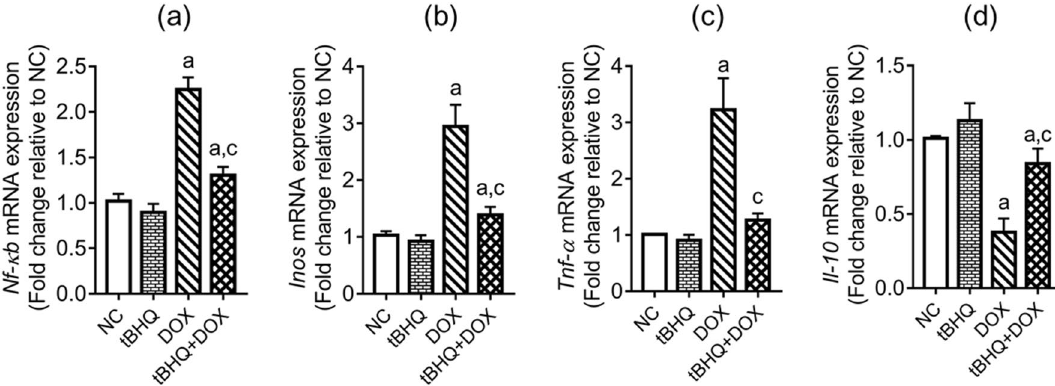
Figure 5. Effect of tBHQ on Nf-κb ( a ), Inos ( b ), Tnf-α ( c ) and Il-10 ( d ) mRNA levels in the testis of DOX- treated rats. NC: normal control, tBHQ: tert-butylhydroquinone, DOX: doxorubicin, tBHQ + DOX: tert- butylhydroquinone + doxorubicin, Nf-κb : nuclear factor kappa B, Inos : inducible nitric oxide synthase, Il : interleukin, Tnf-α : tumor necrosis factor alpha. Values are mean ± SD, n = 6/group. a p < 0.05 versus NC; c p < 0.05 versus DOX (One-way ANOVA with Tukey’s post-hoc test).